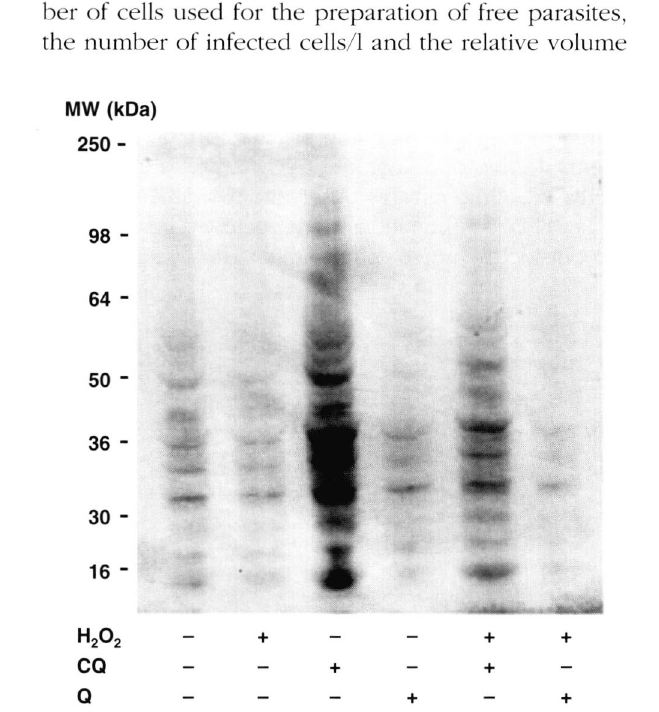
Fig. 2. - Assessment of FPIX as protein ligand. Infected cells were treated with 10 µM CQ or Q for four hours. Free parasites were obtained by saponin lysis and disrupted. Parallel samples were left as controls or treated with 10 uM H minutes at room temperature, electrophoresed by SDS-PAGE and stained for FPIX. Band at ~ 16 kDA is hemoglobin monomers.